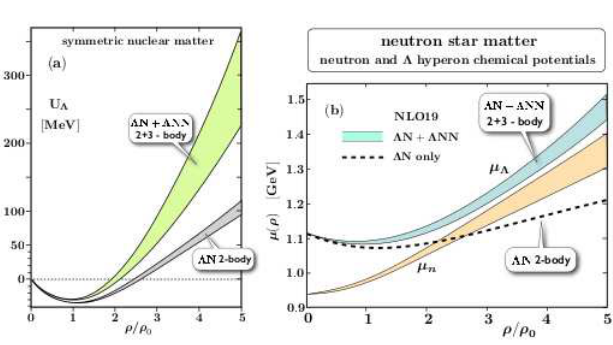
Figure 6. (a) Single-particle potential U Λ of a Λ hyperon in symmetric nuclear matter as a function of baryon density in units of ρ 0 = 0 . 16 fm − 3 . Results of Brueckner-Hartree-Fock calculations us- ing NLO19 two-body Λ N interaction, in comparison with additional Λ NN three-body forces as input. Three-body parameters have been fi xed to the empirical U Λ ( ρ 0 ) ≃ − 30 MeV. (b) Chemical potentials of Λ and neutron, µ Λ and µ n in beta-equlibrated neutron star matter calculated with the same input as in (a). The neutron chemical potential is computed using the chiral nucleon-meson model combined with functional renormalization group methods [21]. In both Figures the bands give an impression of estimated uncertainties. Adapted from